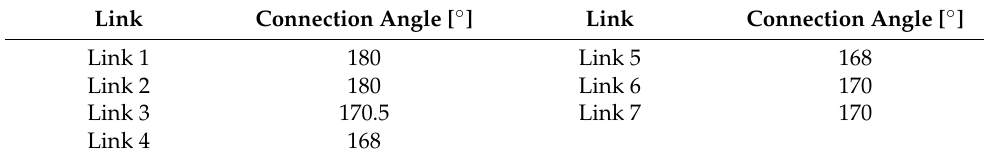
Table 5. Connection angle of